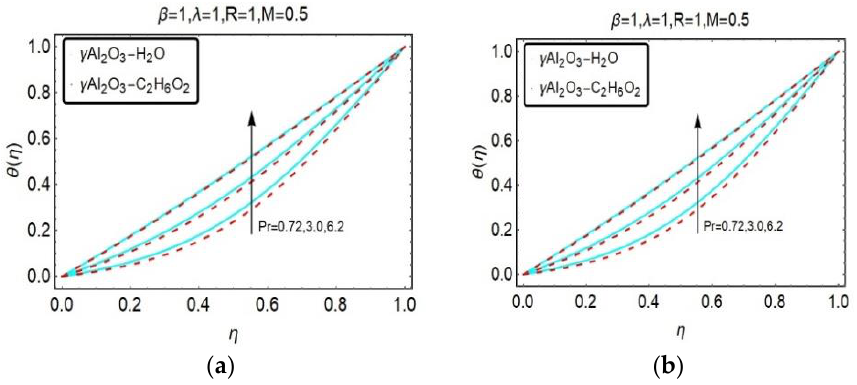
Figure 20. Influence of 𝜙 on 𝜃(𝜂) for (a) 𝑆 > 0 and (b) 𝑆 < 0.